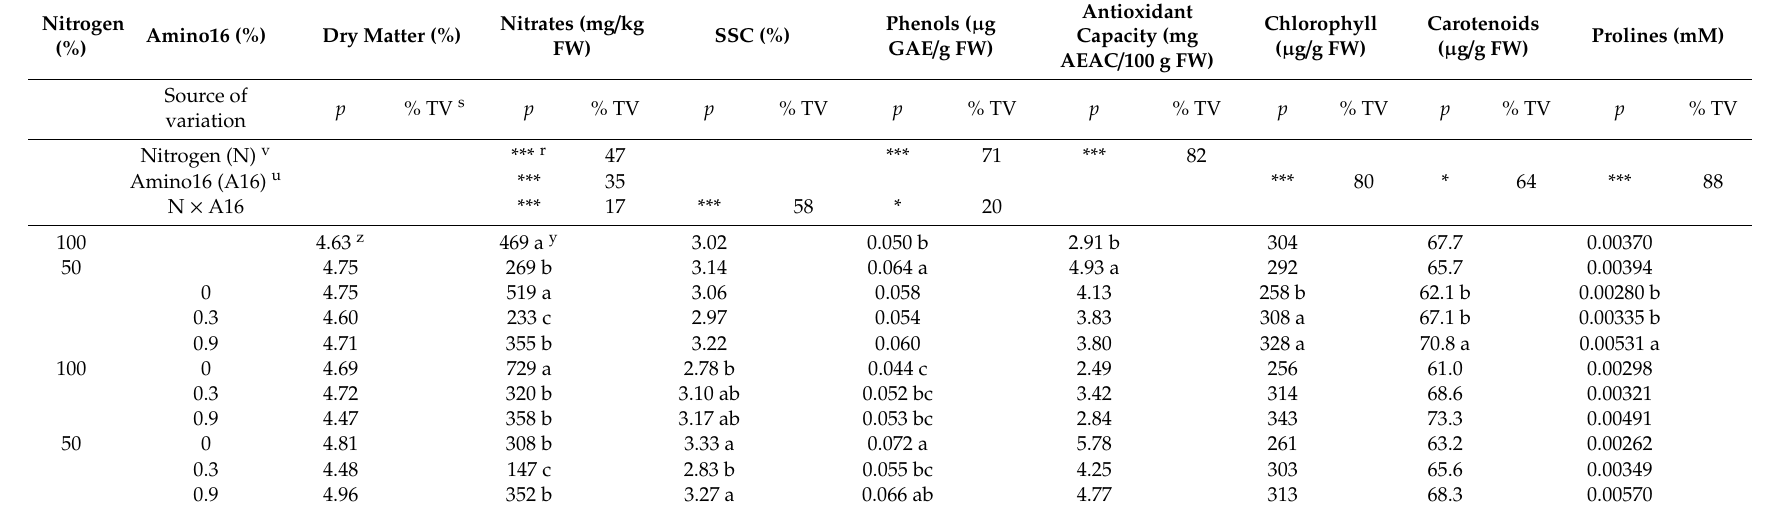
Table 2. Analysis of variance and mean comparison of dry matter, nitrate, soluble solid (SSC), phenolic, total chlorophyll, total carotenoid, and proline content, as well as total antioxidant capacity of green baby lettuce grown in 131 (100%) or 65.5 mg / L (50%) N supplemented with 0, 0.3, or 0.9% Amino16 ®